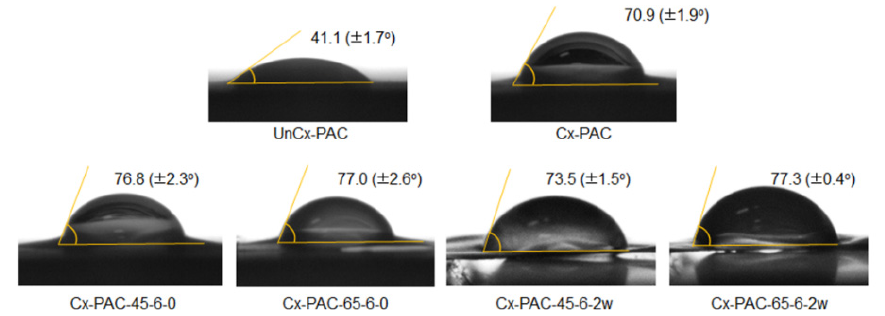
Figure 5. Contact angles of UnCx-PAC and Cx-PAC films aged for zero and two weeks at room temperature after thermal treatment at 45 °C and 65 °C.